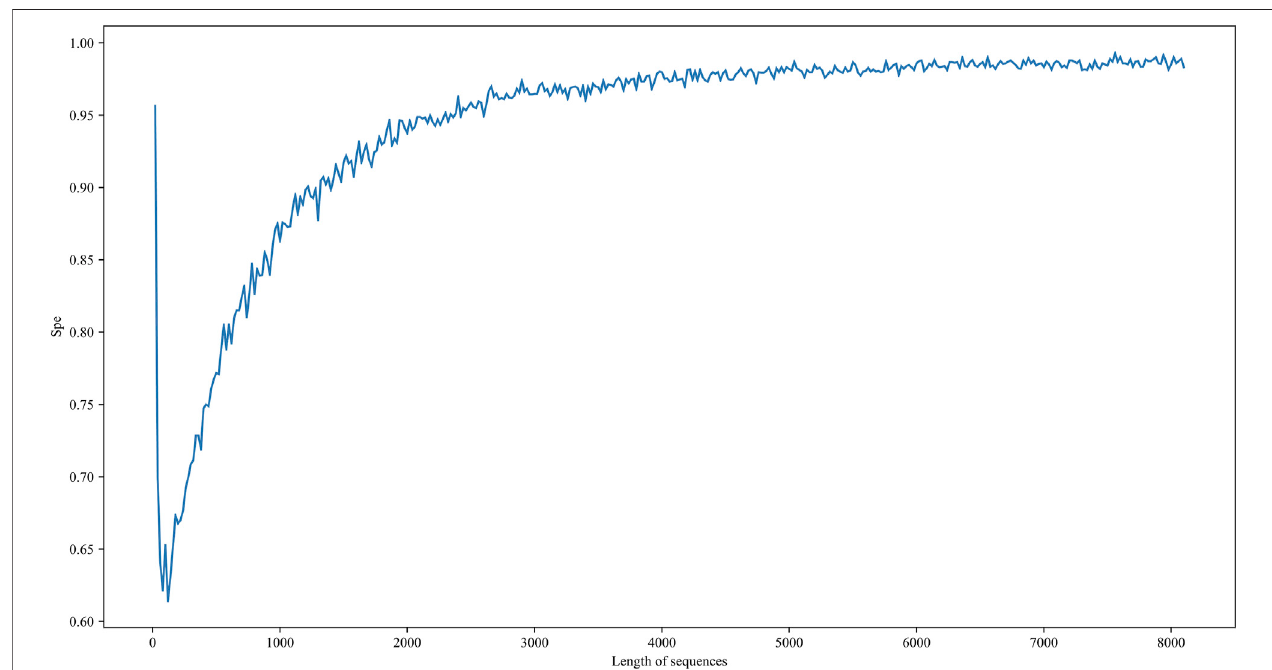
FIGURE7| Performanceofi5hmCVeconthenegativedatasetsofdifferentsequencelengthswithanindependenttest.TheX-axisisthelengthofsequencesinthe negative dataset. The Y-axis is the performance of i5hmCVec on spe.